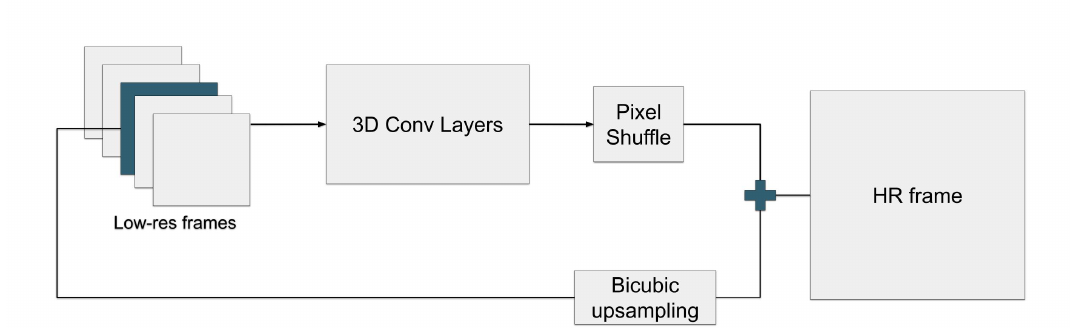
Figure 1. Original 3DSRnet: All low-resolution input frames are fed into the main 3D Conv path to predict the residuals for the middle frame. The results of the paths are added up to obtain the final HR frame.